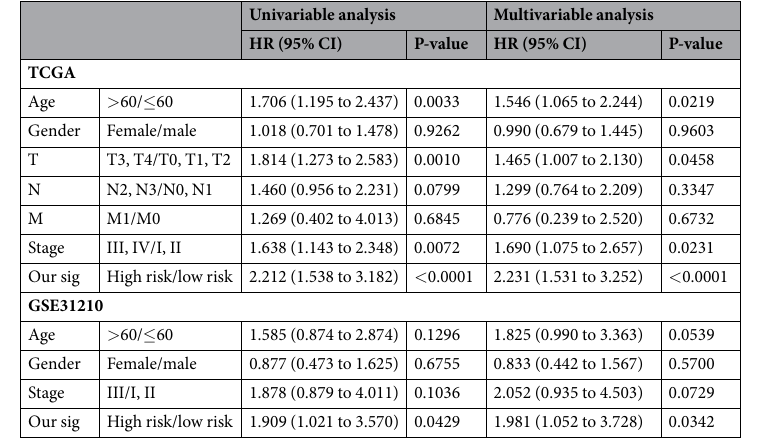
Table 1. Univariable and multivariable analyses of clinical factors and our subpathway